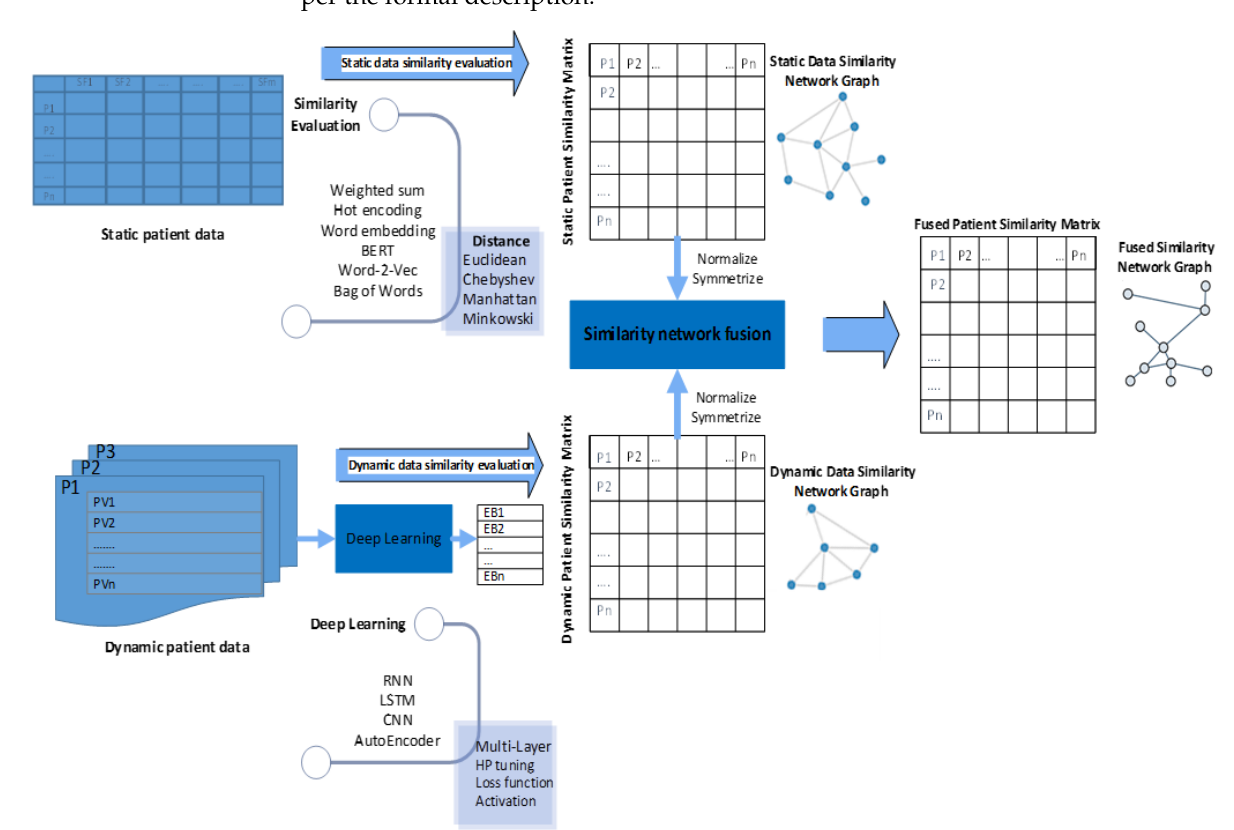
Figure 4. Key processes in building a